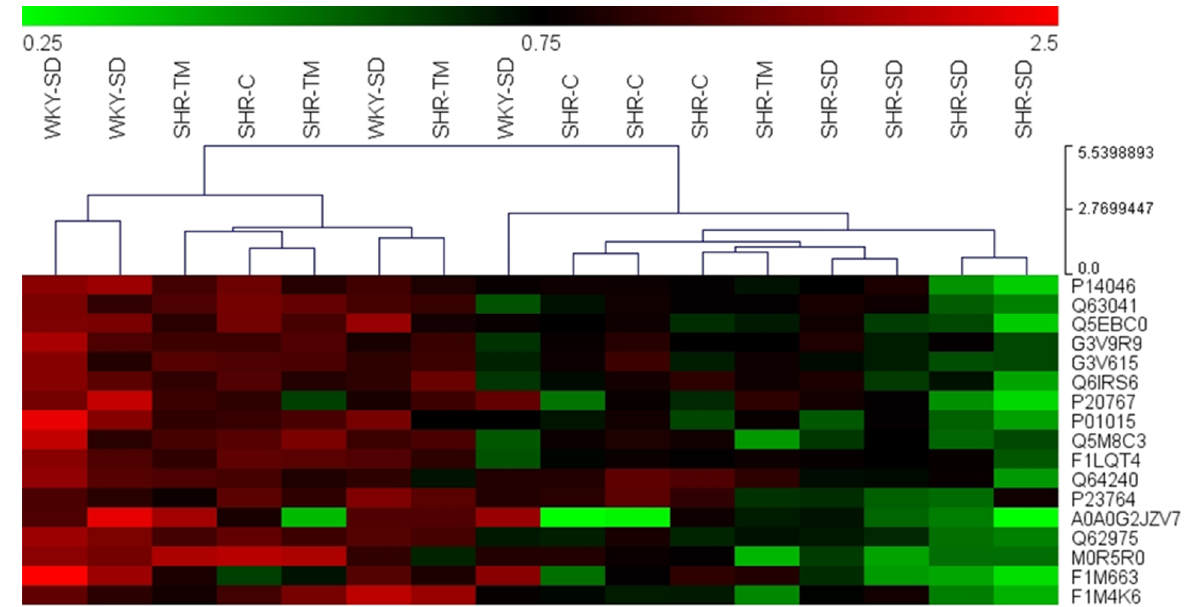
Figure 4. Heat map reporting 17 protein targets of intervention by supplementation with protein extracts from TM. Rows: protein accession number (UniProtKB); columns: animal genotype and experimental groups; color key indicates relative protein amount, red: up-trend; green: down-trend. The protein amount was average normalized.